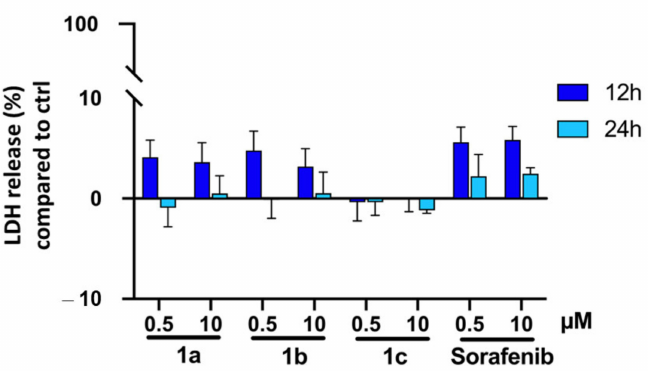
Figure 3. Cytotoxic effects 1a , 1b , 1c and sorafenib. Release of lactate dehydrogenase (LDH) after incubation of HepG2 cells with 0.5 and 10 µ M of 1a , 1b , 1c and sorafenib was not significantly altered when compared to untreated controls (set to 0%), indicating that unspecific toxicity did not contribute to the observed effects. Means ± SD of n = 3 independent experiments.